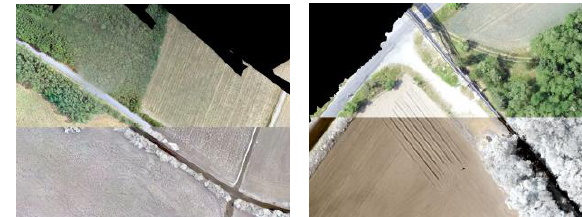
Figure 7 Co-registration improvement (left - separate RGB and NIR flights/processing; right – synchronous RGB+NIR flight and